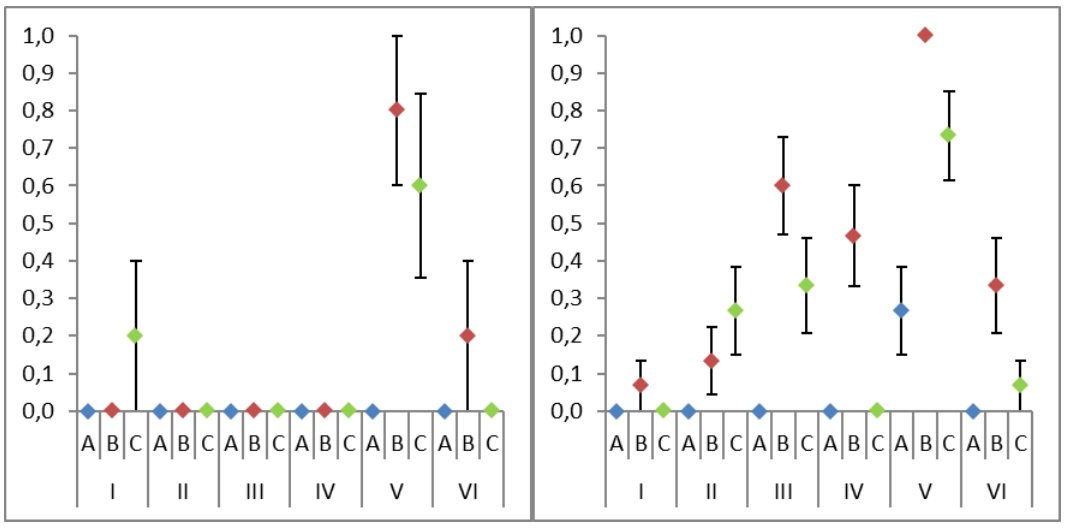
Figure 2. The average DNA isolation success rate of compared lysis (I–VI) and purification methods (A–C). The vertical bars represent standard error (SE).